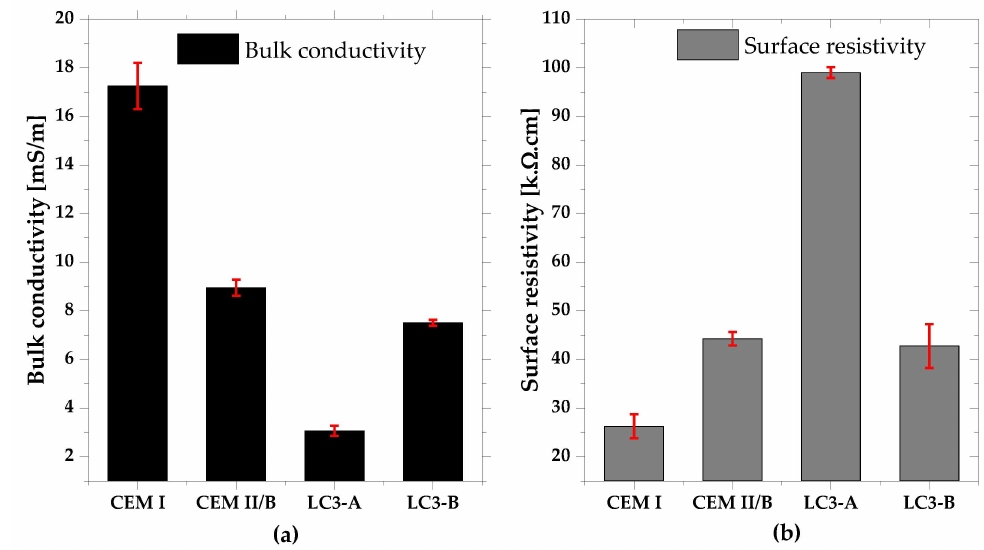
Figure 9. ( a ) Bulk conductivity, and ( b ) Surface resistivity of each